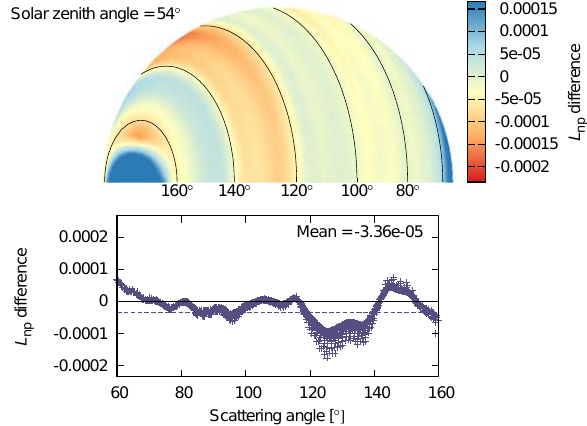
Figure 9. Difference in L np between exact radiative transfer calcu- lations and our simplified forward model. At almost all angles, the difference is less than 1 × 10 − 4 . The polar plot shows the distri- bution of bias when the particle roughness parameter is σ 2 = 0 . 15. The bias is a function of scattering angle. However, the magnitude of error is acceptably small compared to the random observational